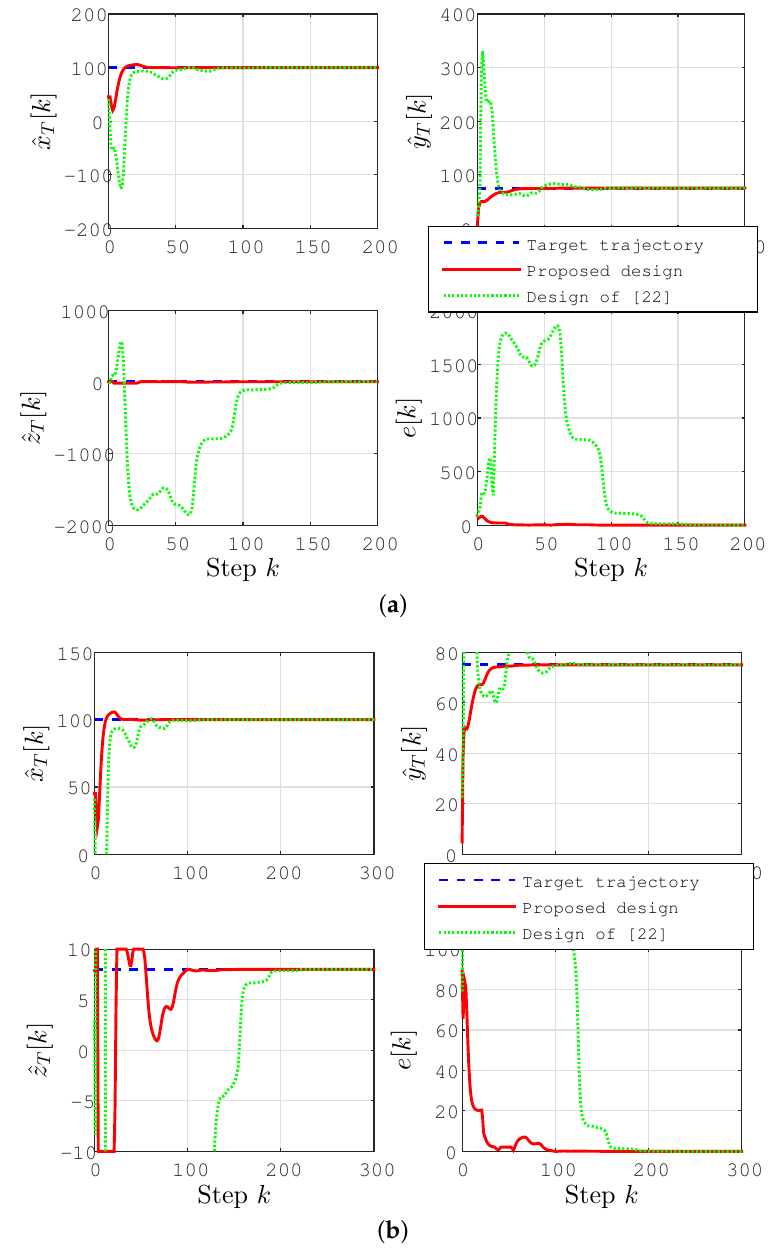
Figure 4. Location estimate ˆ p T [ k ] and estimation error e [ k ] = (cid:107) ˆ p T [ k ] − p T (cid:107) (m) for the stationary target case. ( b ) The scaled version of ( a ) to provide the details of the convergence characteristics for the proposed